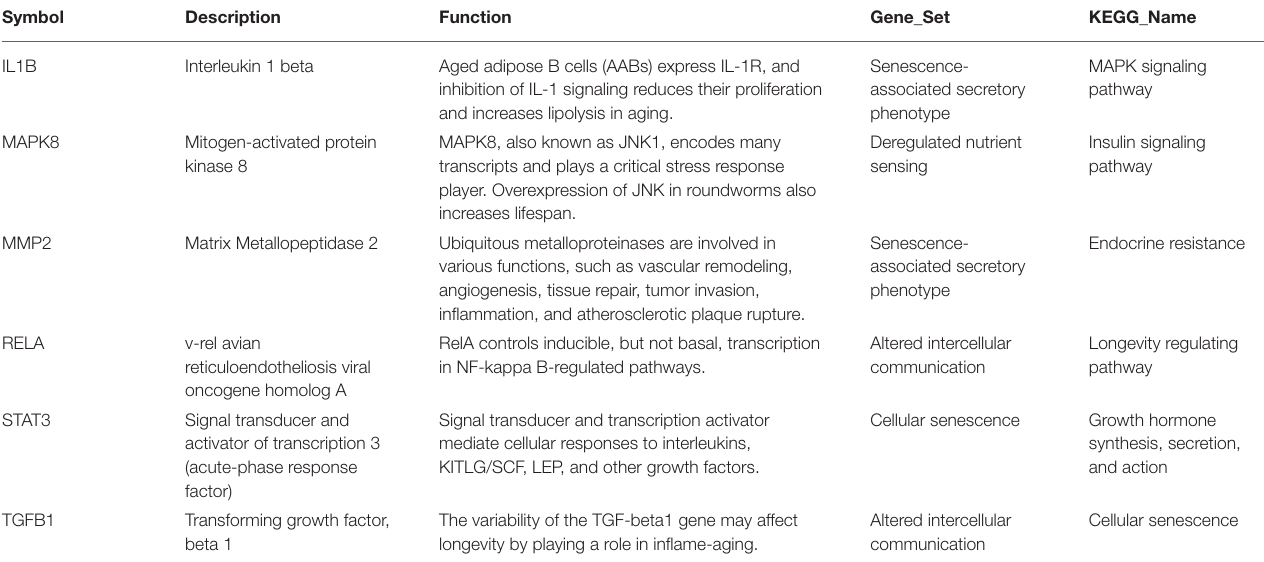
TABLE 3 | The information on six core targets in Aging Altas.